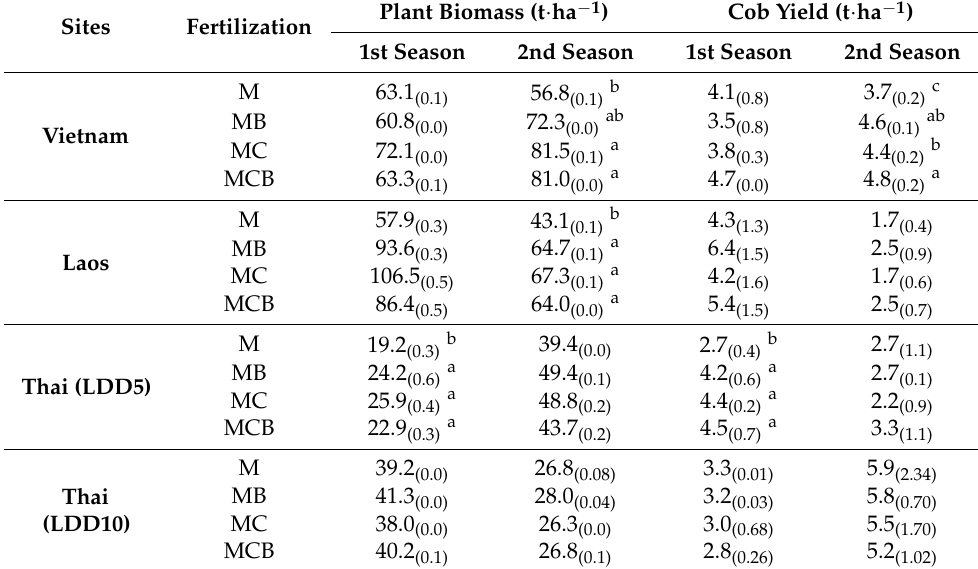
Table 4. Effect of compost and biochar on biomass production of the whole aboveground plant material (plant biomass) and on fresh baby corn yield without husk (Cob Yield) at the maize harvest of two growing seasons. Treatments are represented as follow: (M) mineral fertilizer (NPK) only, (MB) NPK + biochar; (MC) NPK + compost and (MCB) NPK + compost and biochar. Different letter within each country indicate significant differences between